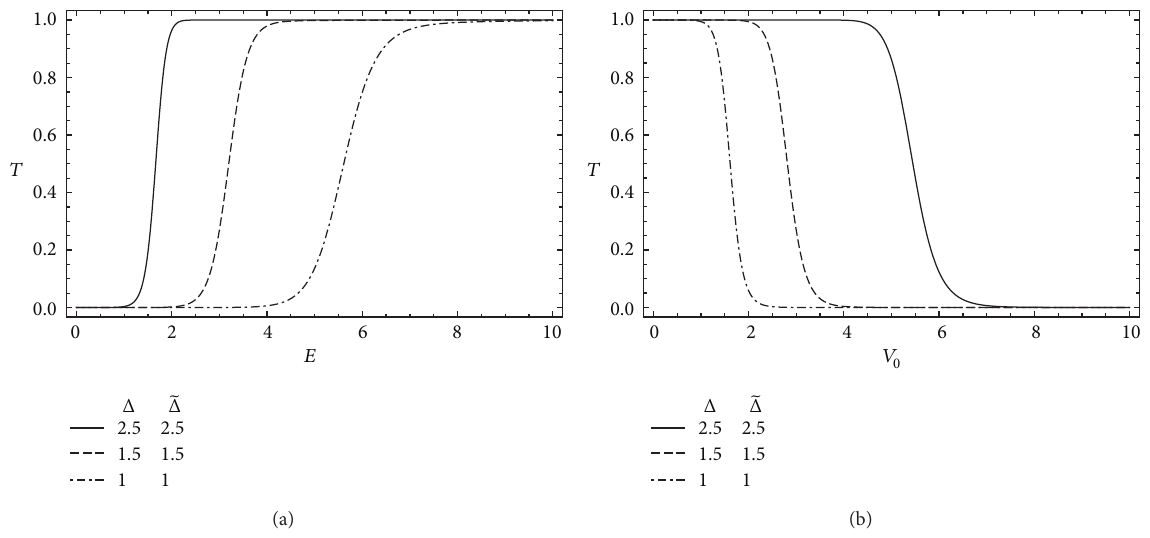
̃Δ ) on the transmission coefficient for 𝛼𝑥 0 = 2 , 𝛽̃𝑥 0 = 4 (lower values of ̃Λ = 1 , 𝐴 = 𝐵 = 𝐶 = 𝐷 = 3 , and 𝑚 = 1 . (b) displays 𝑇 for ̃Λ = 1 , 𝐴 = 𝐵 = 𝐶 = 𝐷 = 𝑉 0 , 𝐸 = 3 , and 𝑚 = 1